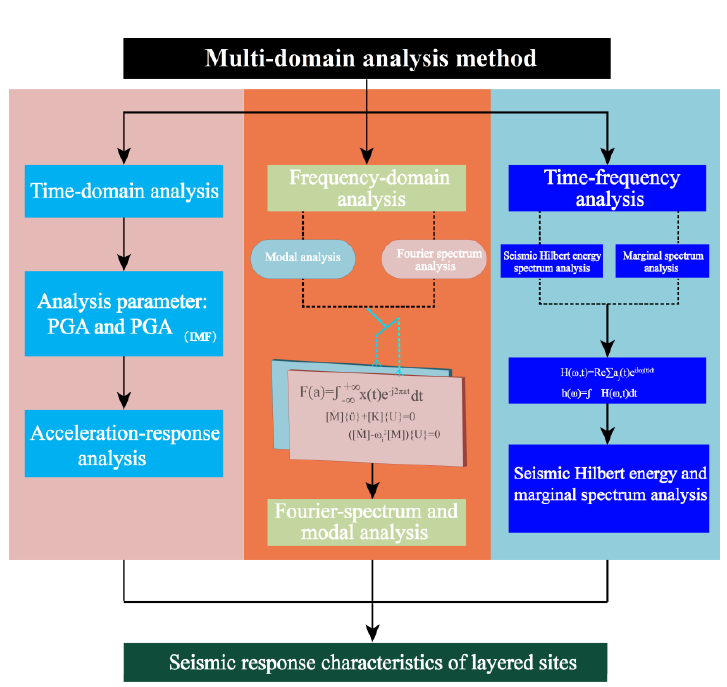
Figure 2. Flowchart for multidomain analysis method.